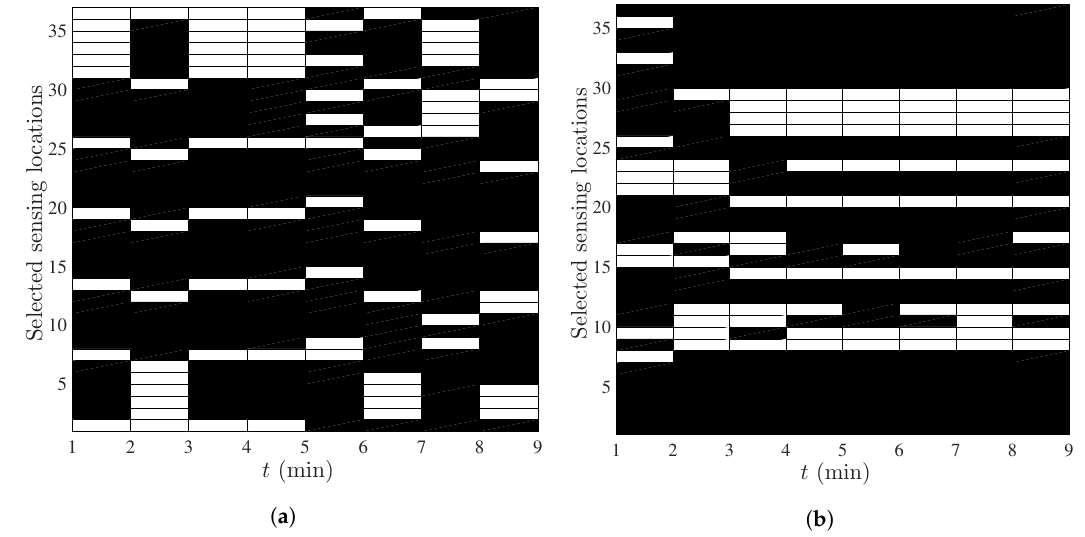
Figure 6. ( a ) Selected sensing locations to estimate the field with the first scenario of the true value; ( b ) Selected sensing locations to estimate the field with the second scenario of the true value.